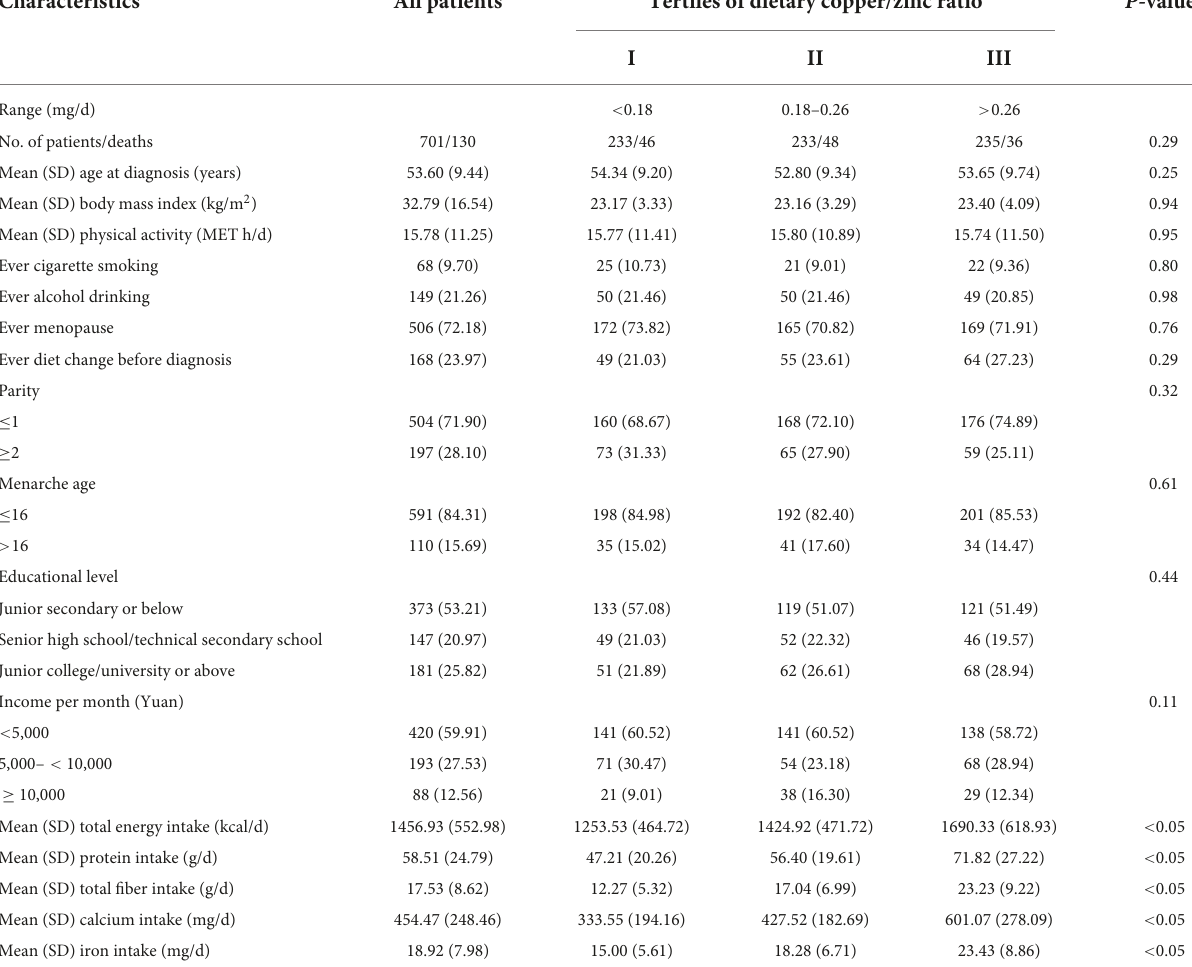
TABLE 2 Baseline characteristics of ovarian cancer patients by tertiles of dietary copper/zinc ratio ( N = 701). Characteristics All